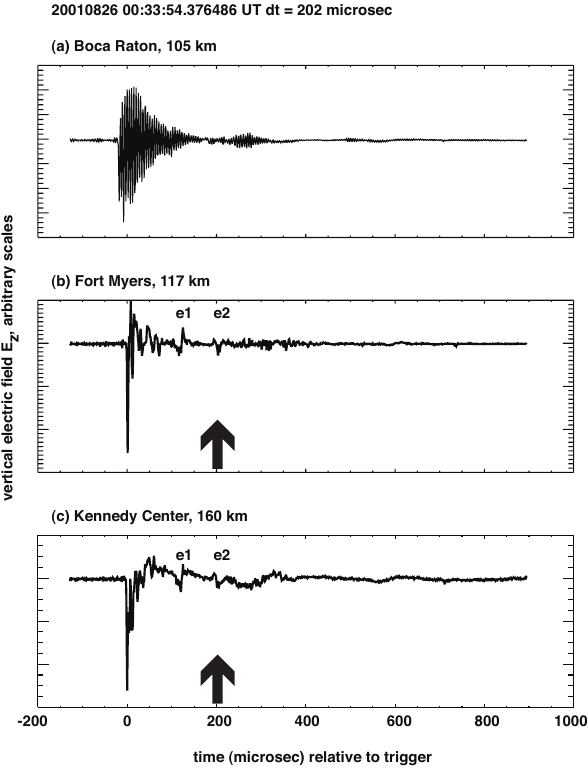
Fig. 7. Single-station sferic recordings for the two tightly- coincident cases lacking full multi-station waveforms. Their au- tomated classification as “NBEs” is clearly erroneous; these are negative cloud-to-ground strokes. The precursor (leader) noise in (b) suggests that this stroke is the first stroke in its flash. See (a) Ta- ble 1, event 2, and (b) Table 1, event